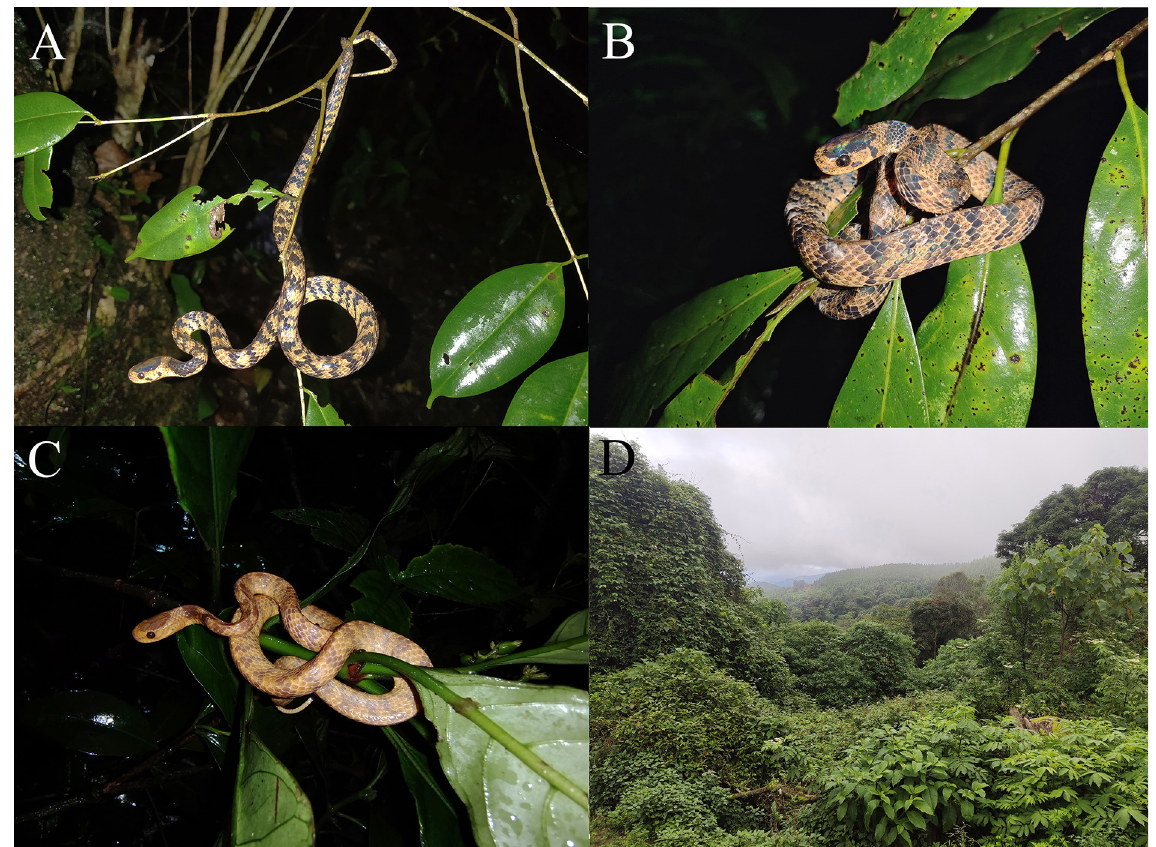
Fig. 7. Pareas tigerinus sp. nov. in life. A . Holotype, ♀ (KIZ 20210705). B . Paratype, ♂ (KIZ 20210703) C . Paratype, ♀ (KIZ 20210704) . D . Habitat at the type locality. Photos by S.